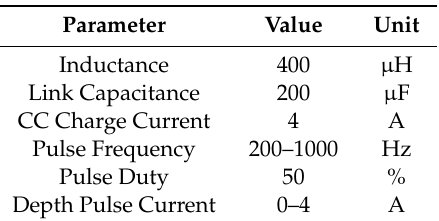
Table 2. Specifications and circuit parameters of the pulse charger.